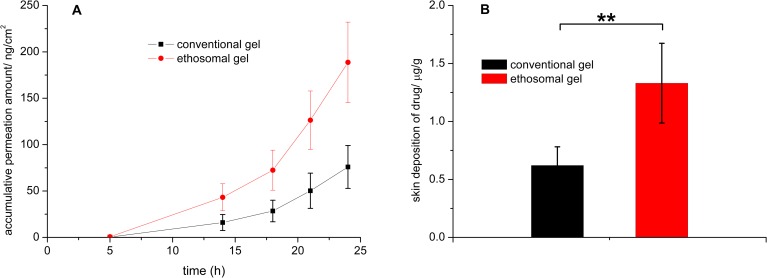
In vitro transdermal profiles (A) and skin deposition (B) of ethosomal gel and conventional gel, (n = 6) **, P<0.01.